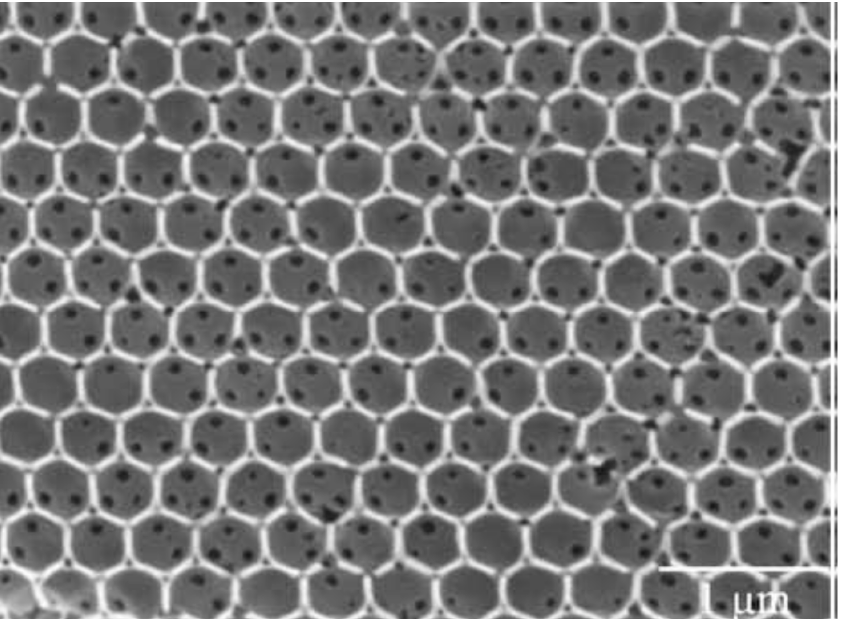
Figure 8. SEM micrograph of silica inverse opal structure, consisting of air spheres in a silica matrix. The template is based on 460 nm polystyrene sphere-derived photonic crystal made by convective self-assembly from a 0.1 wt% suspension in water. Reproduced with modification and permission from [76], copyright 2009, Elsevier.